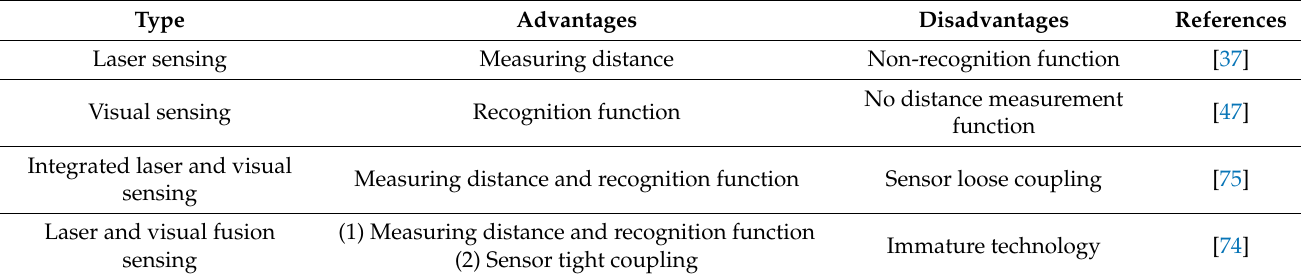
Table 3. Laser sensing, vision sensing, integrated sensing, fusion sensing smart